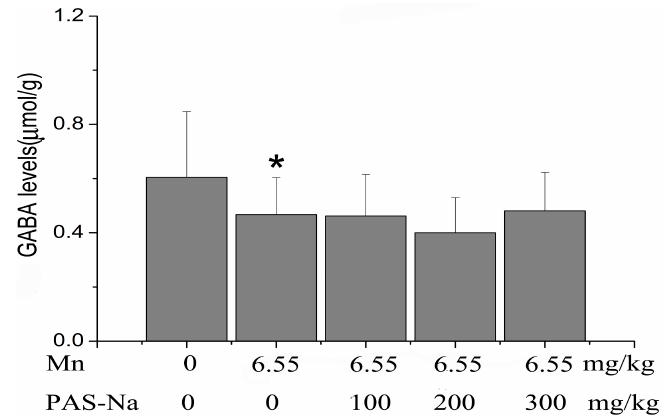
Figure 3. PAS-Na failed to reverse the Mn-induced decrease of GABA levels in the basal ganglia. Data represent mean ± SD. N = 5 per group. * p < 0.05: significant as compared to